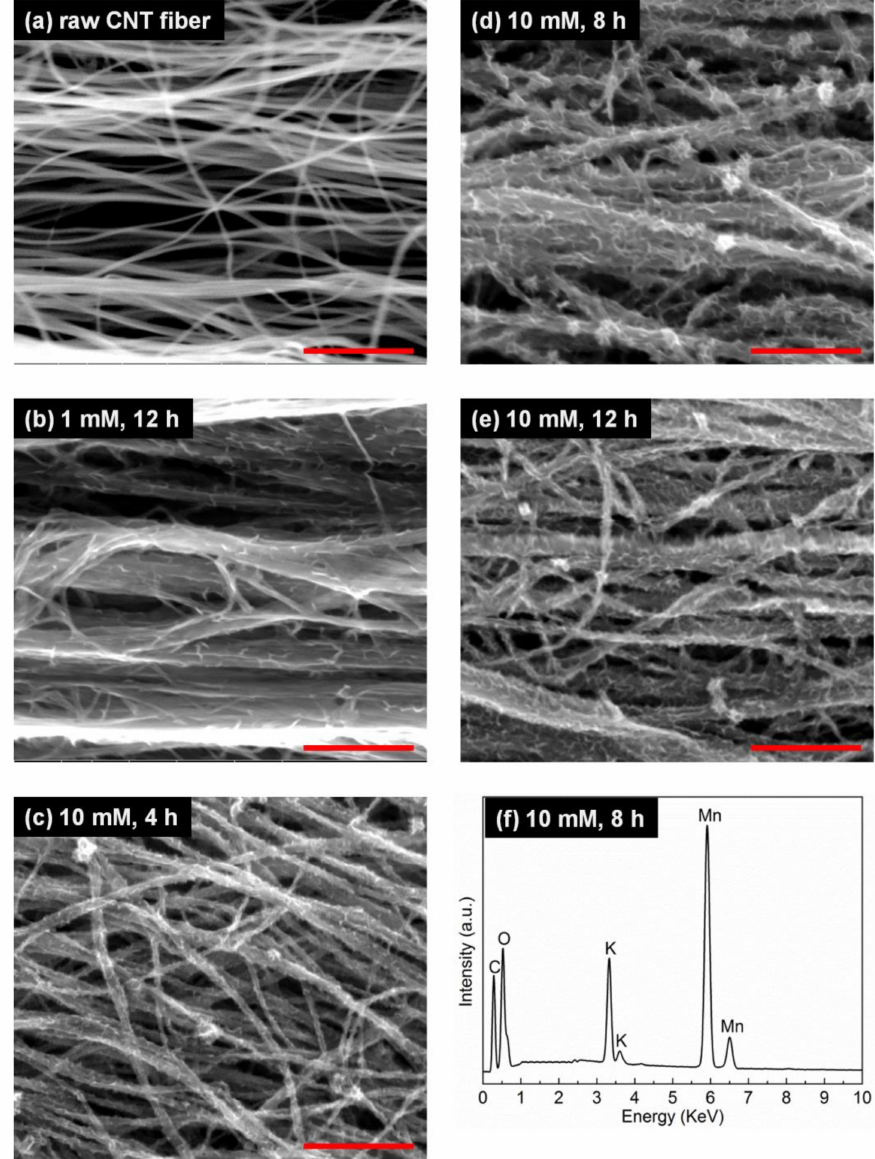
Figure 2. SEM images of ( a ) raw CNT fiber and ( b ) CNT–MnO 2 fiber (1, 12), ( c ) (10, 4), ( d ) (10, 8), and ( e ) (10, 12). ( f ) EDS pattern detected from CNT–MnO 2 fiber (10, 8). Scale bars equal 500